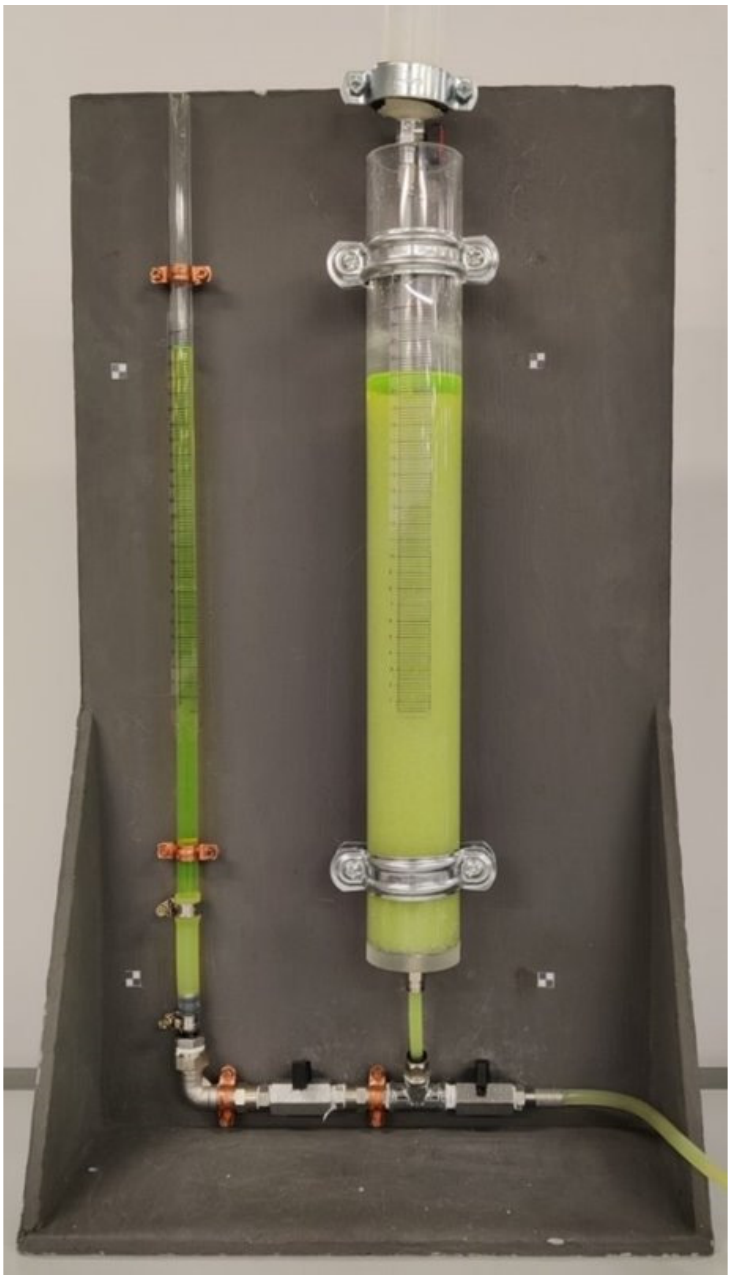
Figure 1. Experimental equipment for the column filled with glass beads of 1 mm diameter as the porous media and saturated with water and fluorescein.